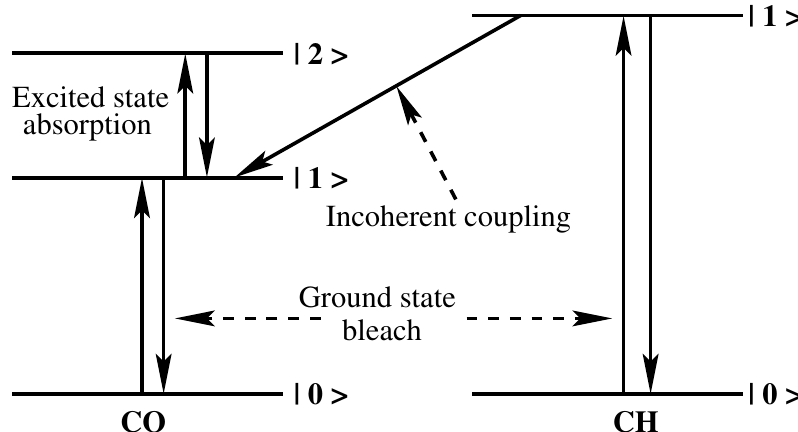
Figure 11. Incoherent coupling: Relaxation of energy from the first excited energy level of the C-H stretch vibrational band to the first excited energy level of the amideI